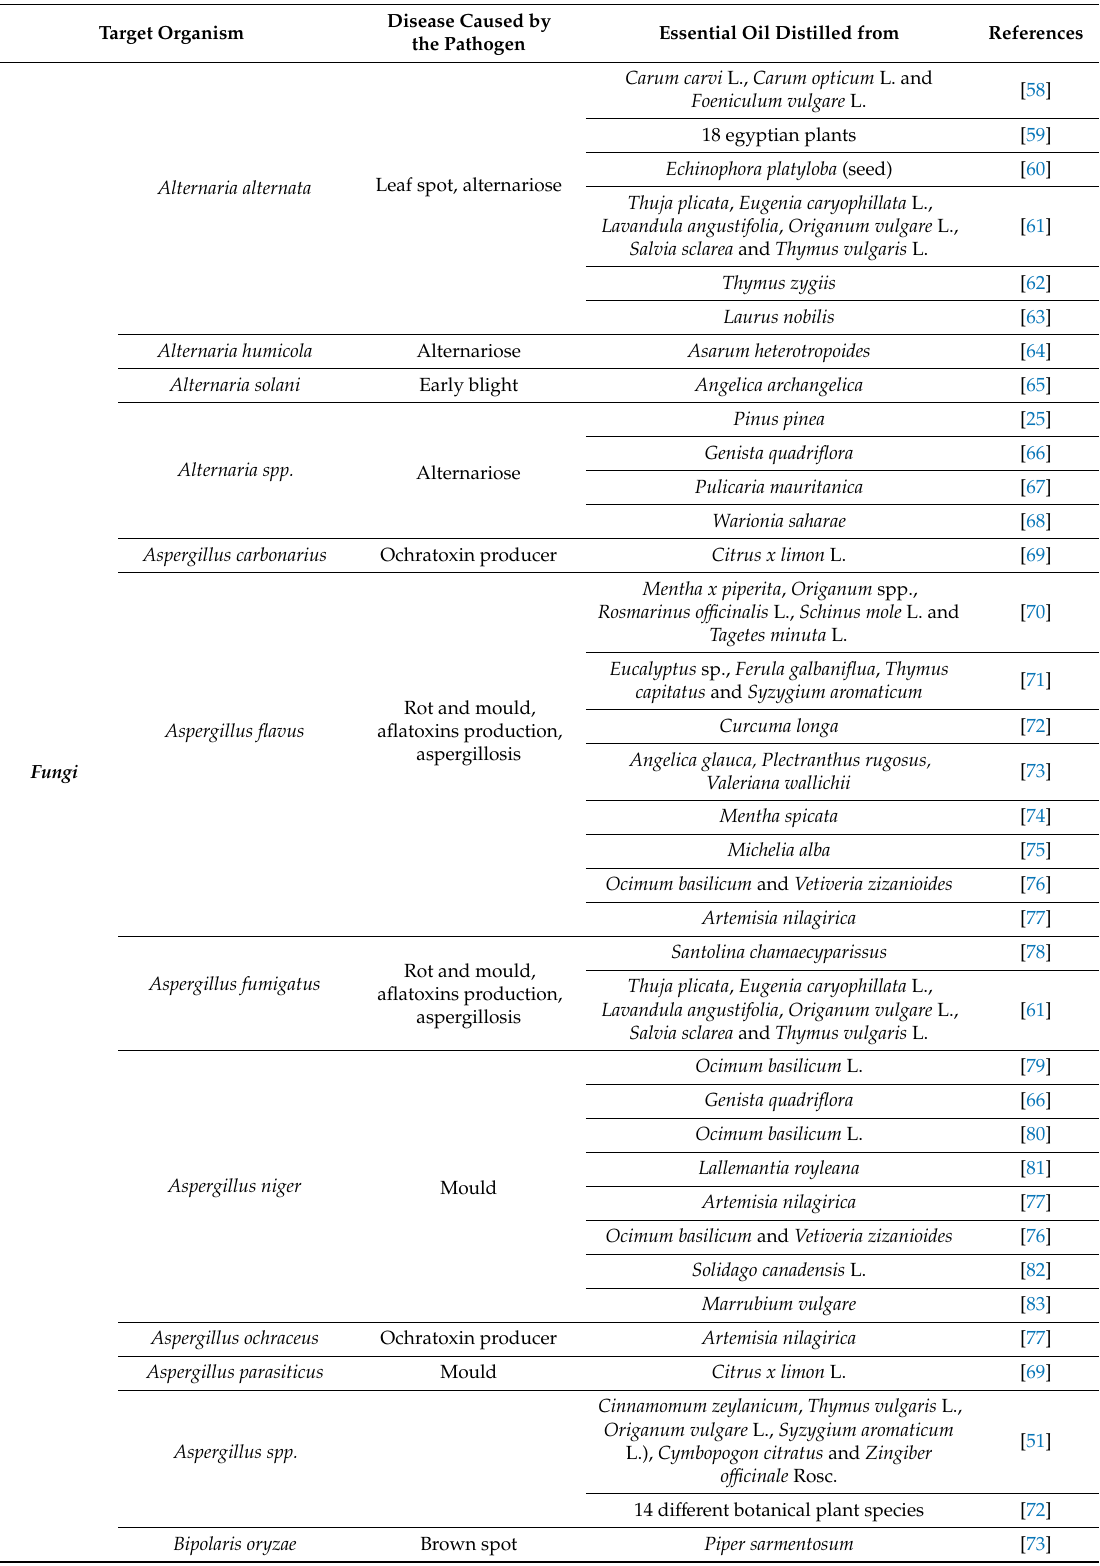
Table 1. Antifungal properties of essential oils (EO) against phytopathogenic fungi and oomycetes studied during the last